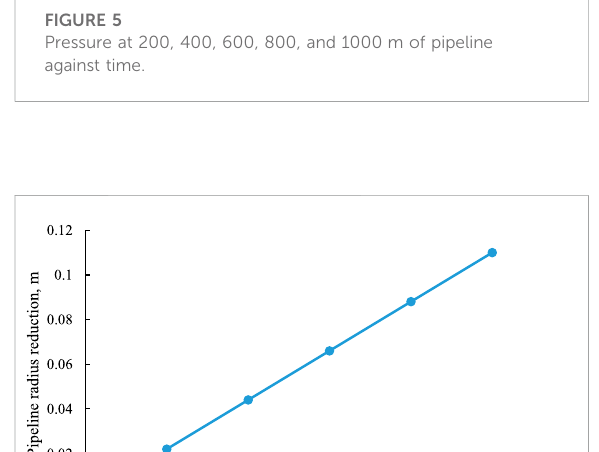
FIGURE 5 Pressure at 200, 400, 600, 800, and 1000 m of pipeline against time.